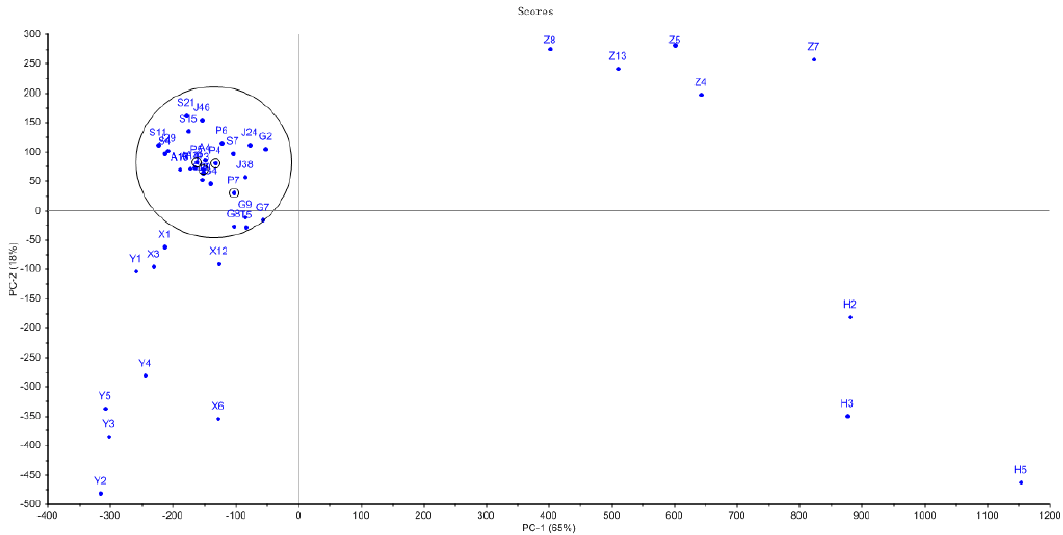
Figure 4. The Unscrambler of high-performance liquid chromatography (HPLC) chemometrics analysis of 44 samples of Fritillariae Bulbus.